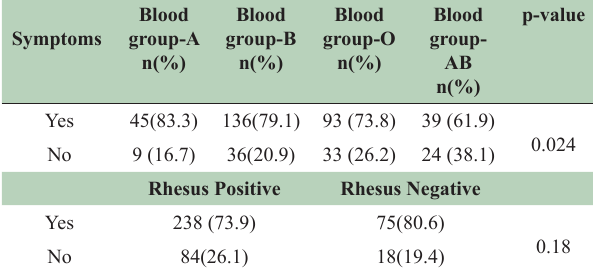
Table-II: Association of COVID-19 Symptoms with blood groups.